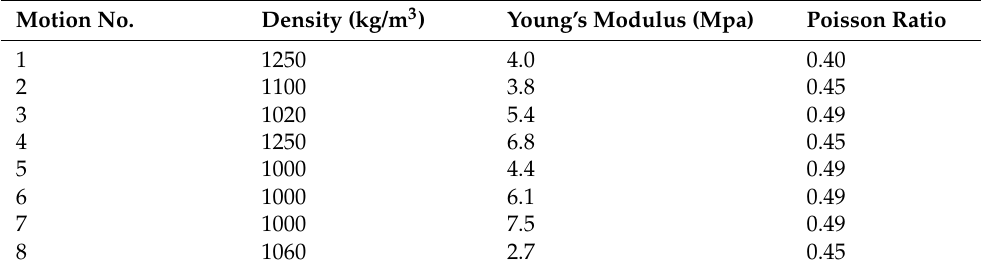
Table 9. Material properties of aortic valves with eight motions in test dataset.